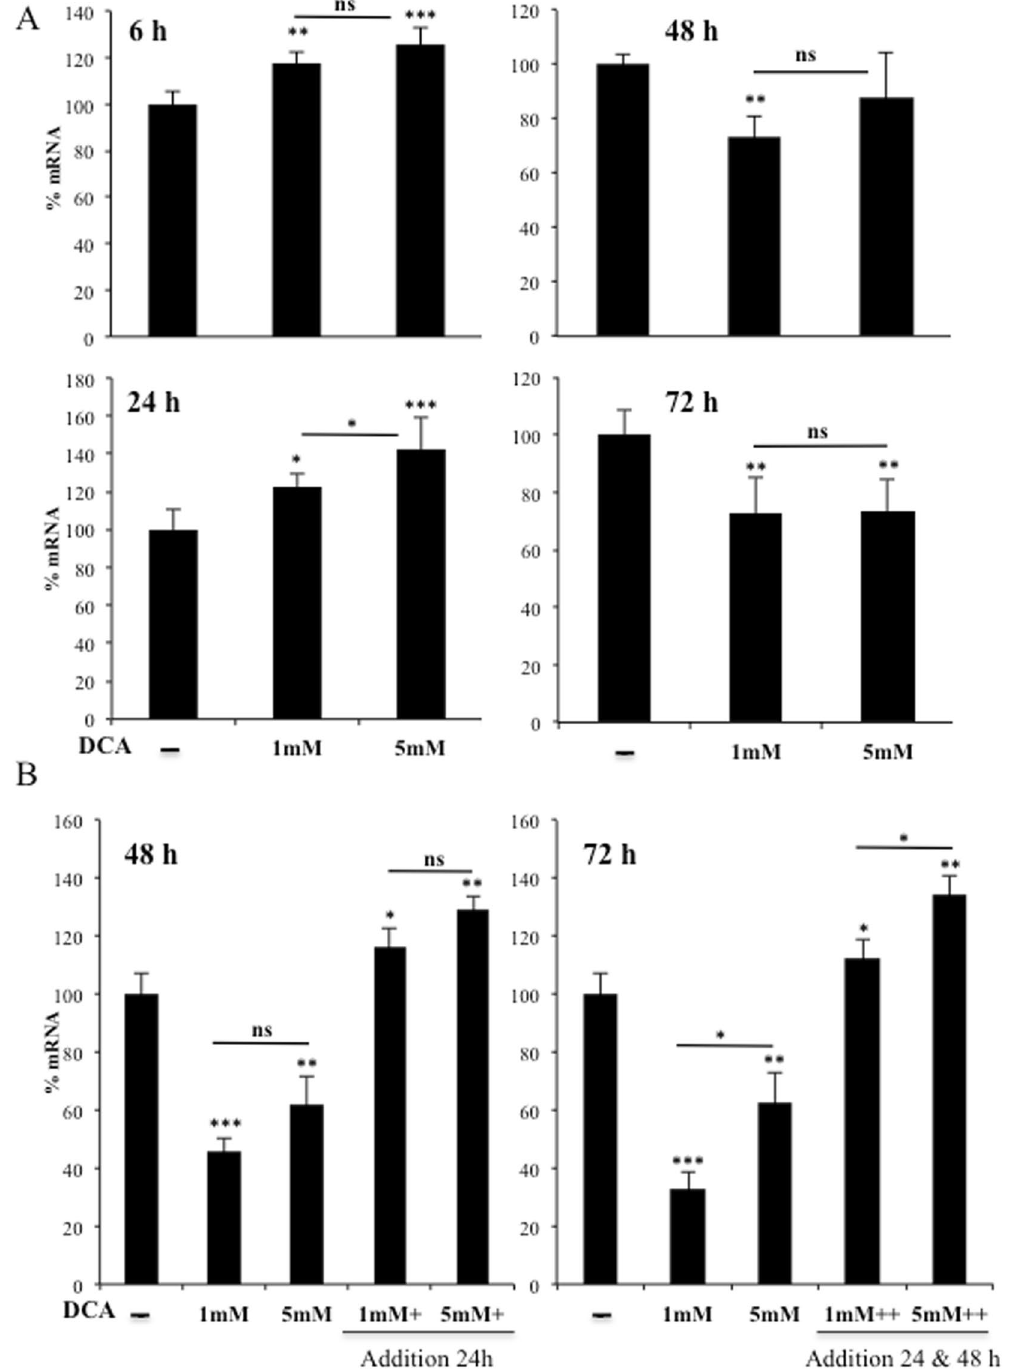
Figure 2. DCA induced LDLR expression in primary human hepatocytes. ( A ) Primary hepatocytes were treated with the indicated concentrations of DCA for the indicated times. ( B ) Cells were treated at time 0 with DCA and some were treated every 24 h before harvesting as indicated. LDLR mRNA was analyzed by RT-qPCR. The bar graphs represent means ± SD of 3 independent donors performed in triplicate; * p < 0.05, ** p < 0.01, *** p < 0.005 one-way ANOVA with post-hoc Tukey